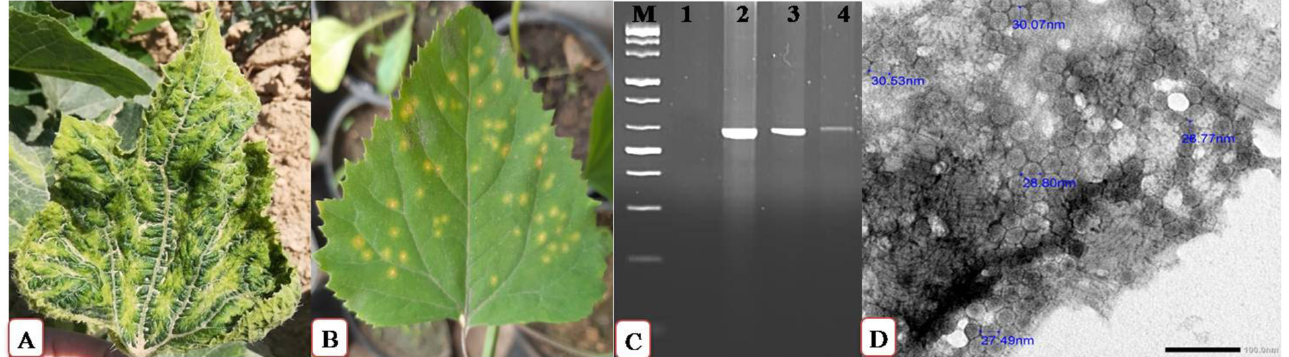
Figure 1. Squash ( Cucurbita pepo L.) leaves showing mosaic-like symptoms, chlorosis, vein banding, and leaf malformation following a systemic infection by Cucumber mosaic virus (CMV) at 12 dpi ( A ). Single local lesions develop in CMV-inoculated Chenopodium amaranticolor leaves at 4–5 dpi ( B ). RT-PCR with primers specific for the CMV-CP gene detected an amplicon of 600 bp (M, 100bp ladder, 1, negative control, 2, CMV-infected squash, 3, and 4, C. amaranticolor local lesions induced by CMV) ( C ). Transmission electron microscopy (TEM) revealed that the purified CMV particles are spherical and approximately 30 nm in size ( D ).